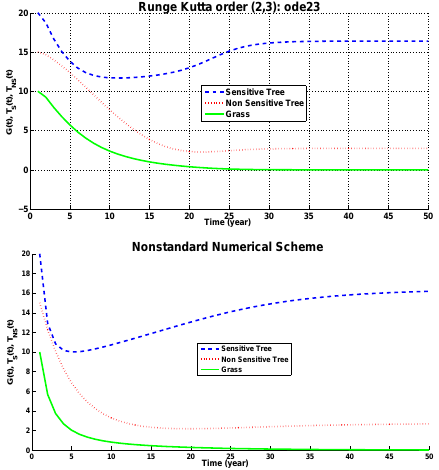
Fig. 10. For these figure, µ G = 0 . 4. The ODE’s routine which is a standard numerical algorithms shows a spurious negative solutions.